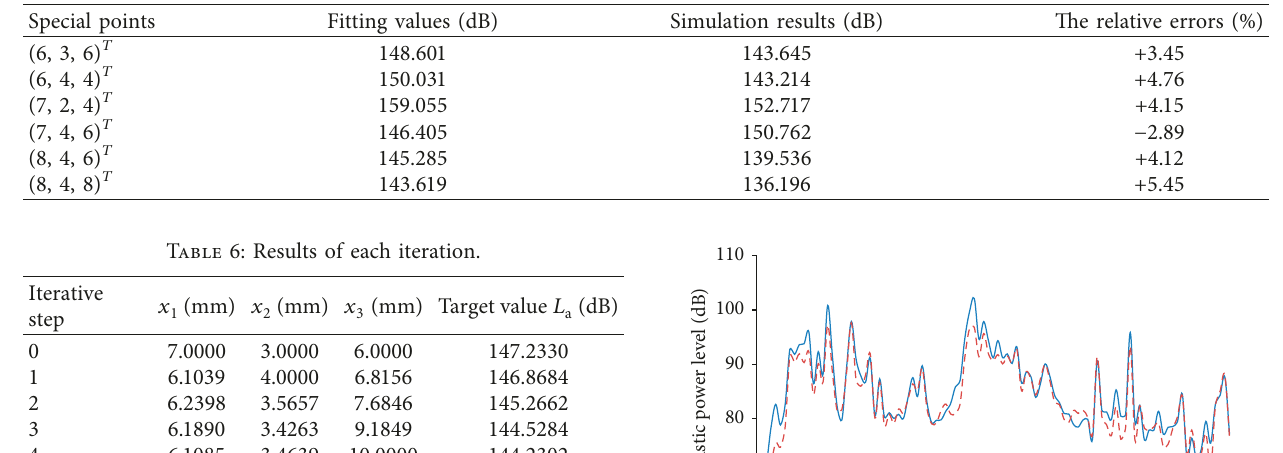
Table 5: Comparison of fitting values and simulation results.